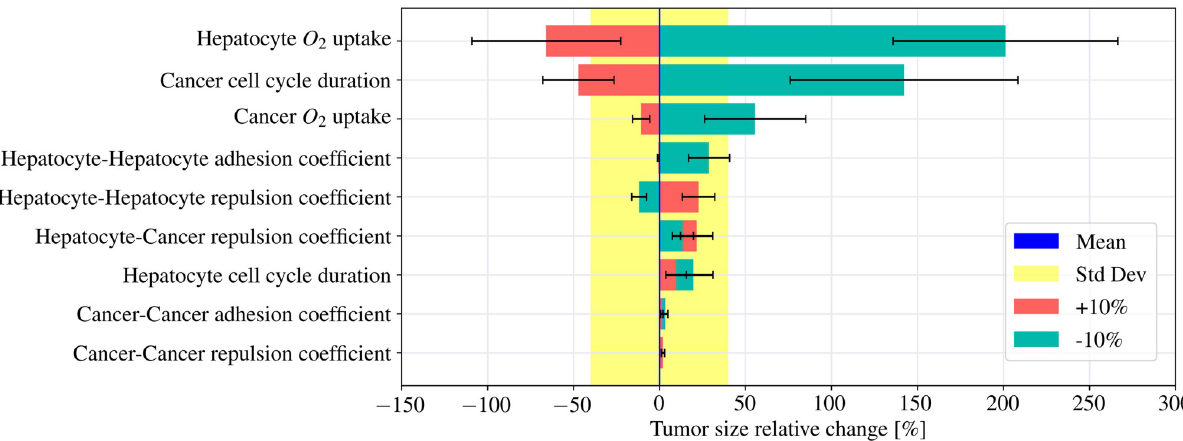
Fig 11. Sensitivity study. Relative change of the tumor final size, based on the variation of the parameters that feed our model. The blue line represents the mean tumor size, the yellow shaded region represents the standard deviation of the mean value based on the stochasticity of the model. Red bars and blue bars represent the mean value of the tumor growth when the parameter original value is increased and decreased by 10% respectively and the error bars represent the standard deviation. The three parameters most likely to make an impact on the tumor growth are: the hepatocyte oxygen uptake constant, cancer cells cycle duration and cancer cells oxygen uptake